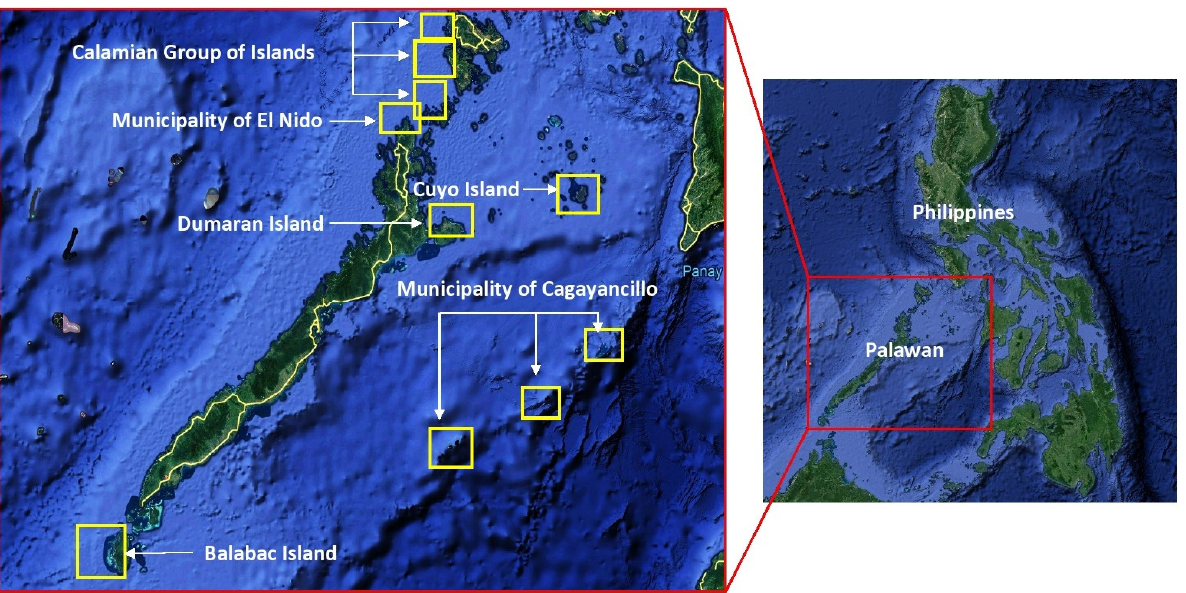
Figure 1. Probable sites for wave energy development (yellow boxes) in the province of Palawan identified by University of the Philippines’ Marine Science Institute.